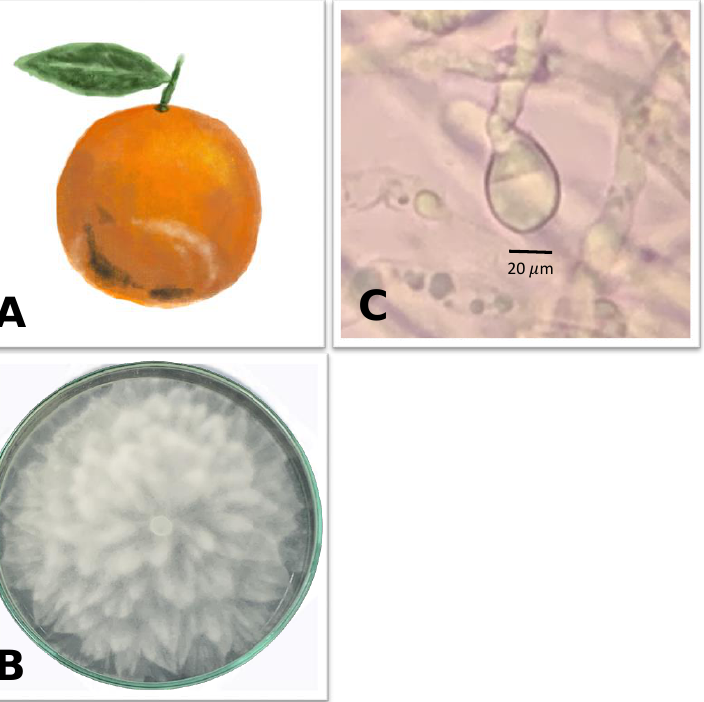
Figure 2. Brown rot of citrus fruit causes by Phytophthora spp., ( A ) = the symptom on fruit; ( B ) = colony and ( C ) = morphology of sporangia.